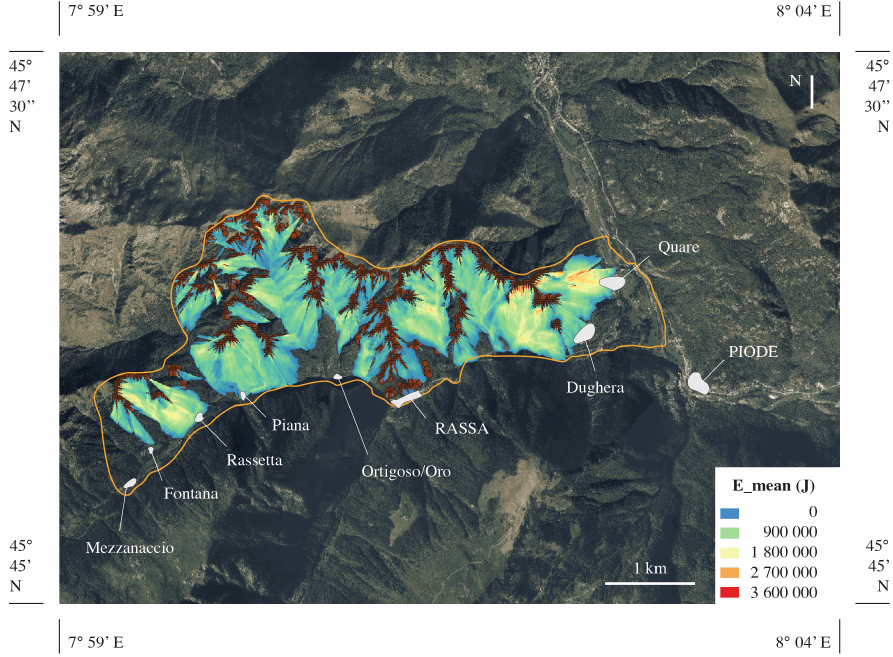
Figure 4. Mean energy map for the forecasting analysis of the 1 m 3 rockfall scenario.